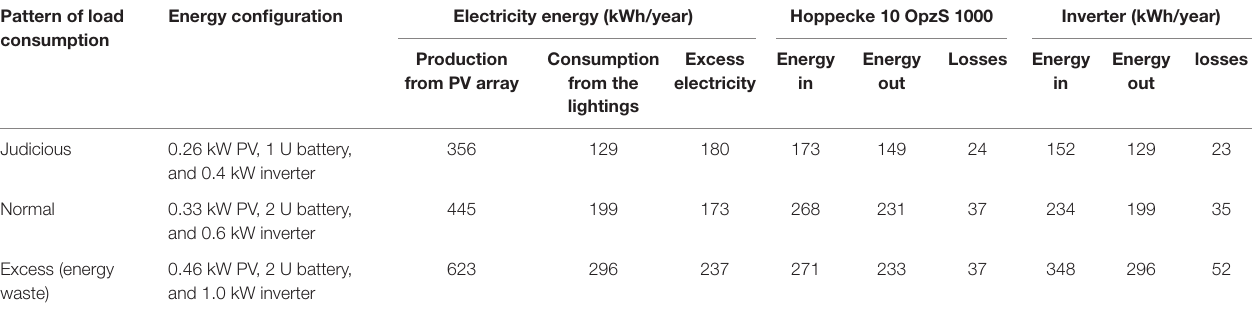
TaBle 3 | simulation results of electricity production, consumption, and losses (with hoppecke battery).